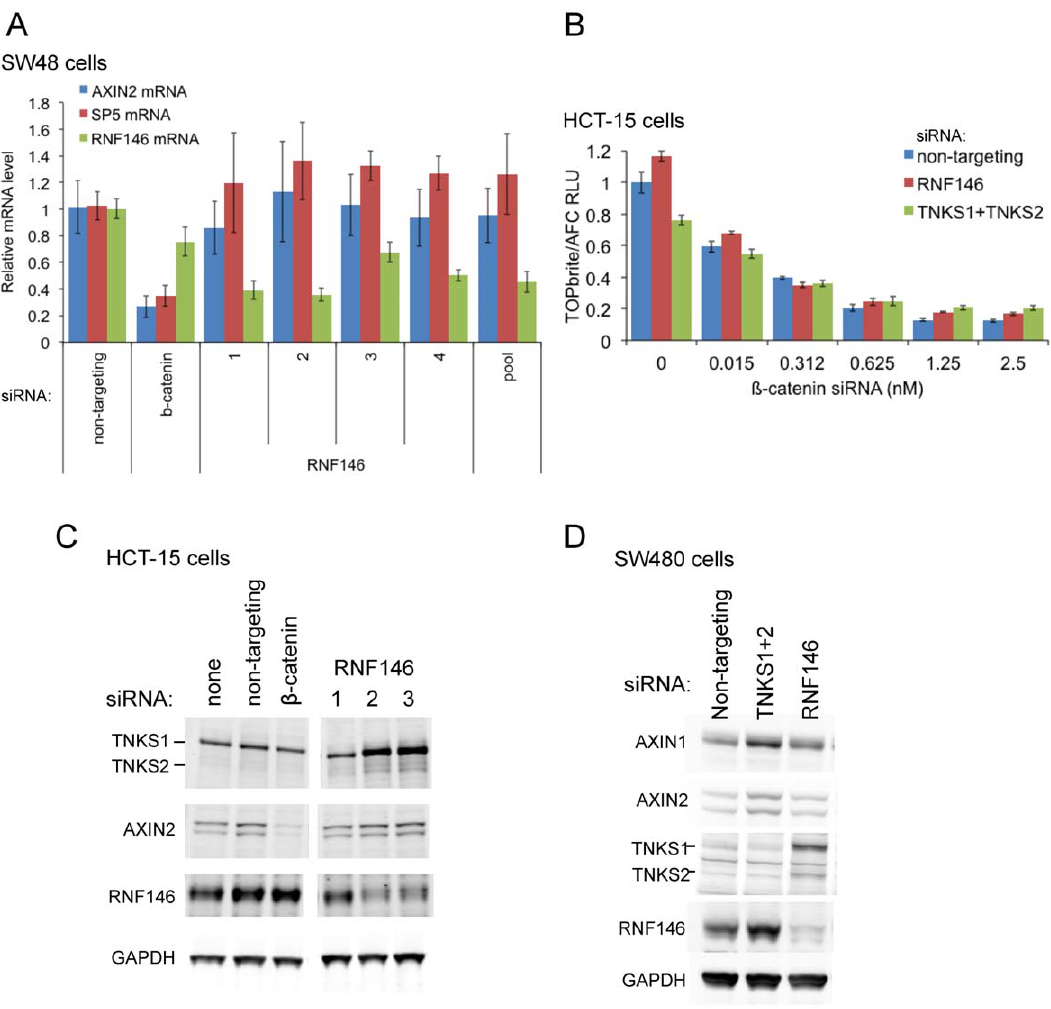
Figure 4. RNF146 RNAi does not inhibit Wnt signaling in b -catenin or APC mutant colorectal cell lines. (A) Expression levels of endogenous b -catenin-activated genes AXIN2 (blue) and SP5 (red) in SW48 cells after transfection of individual or pooled RNF146 siRNAs. b -catenin and non-targeting siRNAs serve as positive and negative controls, respectively, and the level of knockdown of RNF146 mRNA expression is indicated in green. (B) Co-transfection of RNF146 (red), tankyrase (both TNKS1 and TNKS2; green), or control non-targeting siRNA with b -catenin siRNA at the indicated concentration in HCT-15 cells stably expressing TOPbrite Wnt reporter. Reporter activity is normalized to cell number and non-targeting siRNA treatment alone. (C–D) Western analysis of tankyrase, Axin, and RNF146 protein levels in HCT-15 (C) or SW480 (D) cells after siRNA treatment targeting the indicated genes.